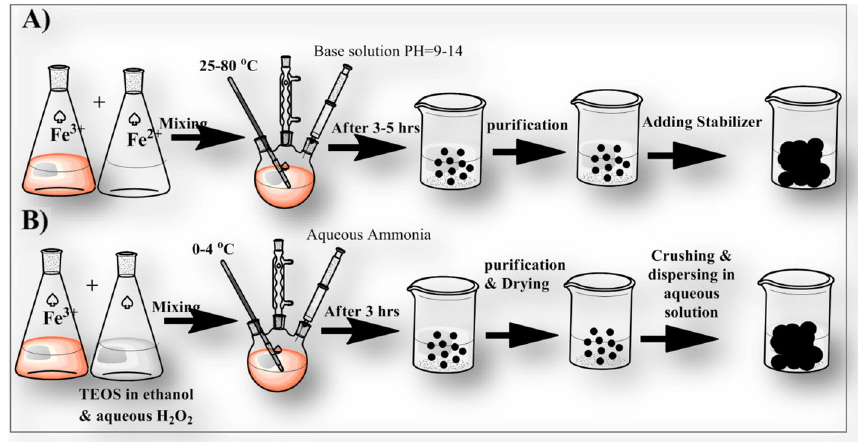
Fig. 3 Chemical methods of magnetite nanoparticle synthesis A co-precipitation method and B sol–gel